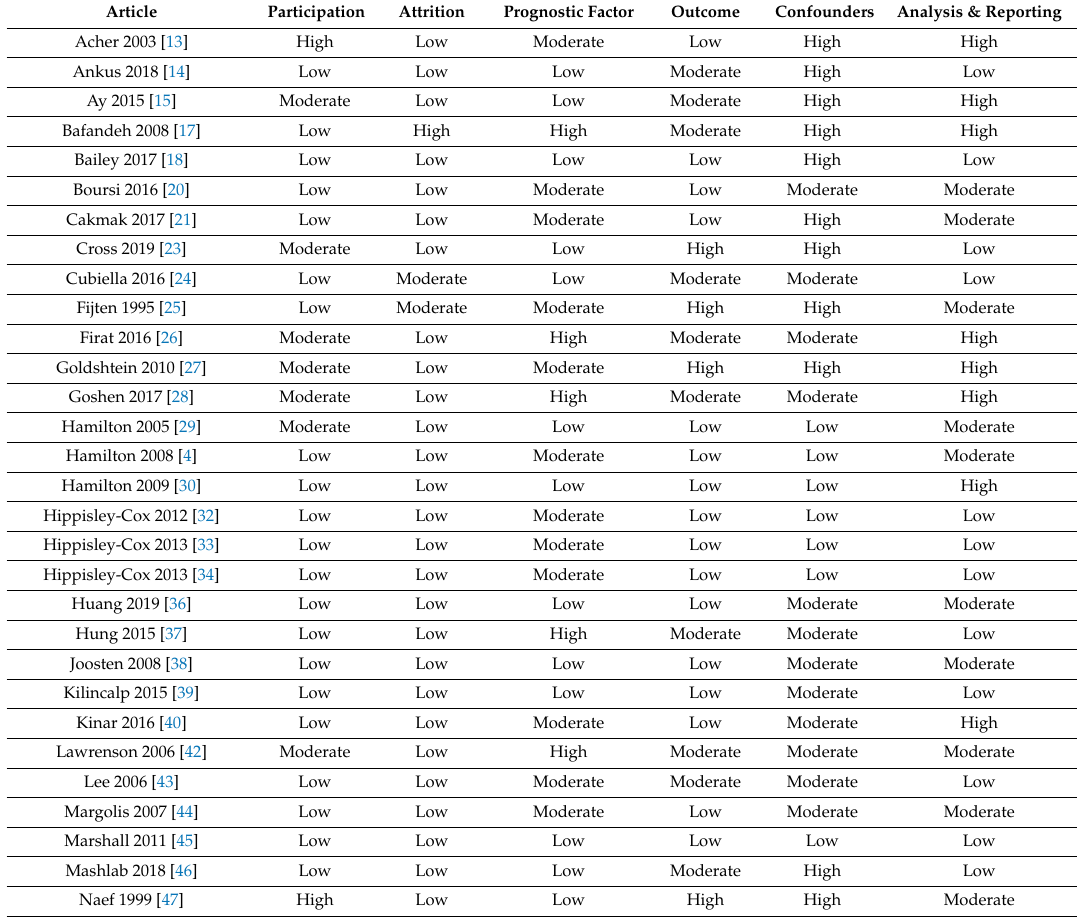
Table 2. Risk of bias in the 47 studies assessing an association between the full blood count and colorectal cancer diagnosis, assessed using the QUIPS